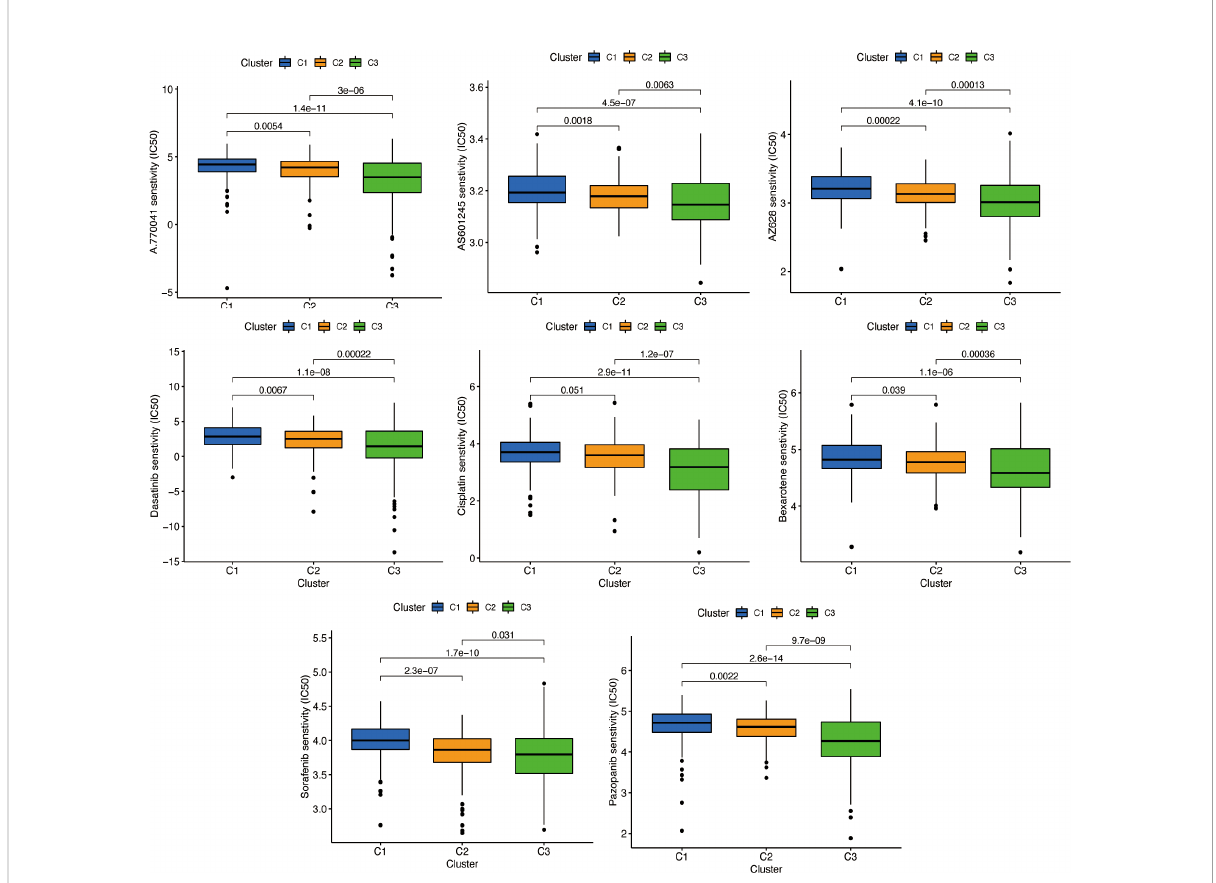
FIGURE 14 Prediction of potential chemical drugs. These drugs all had higher IC50 in Cluster